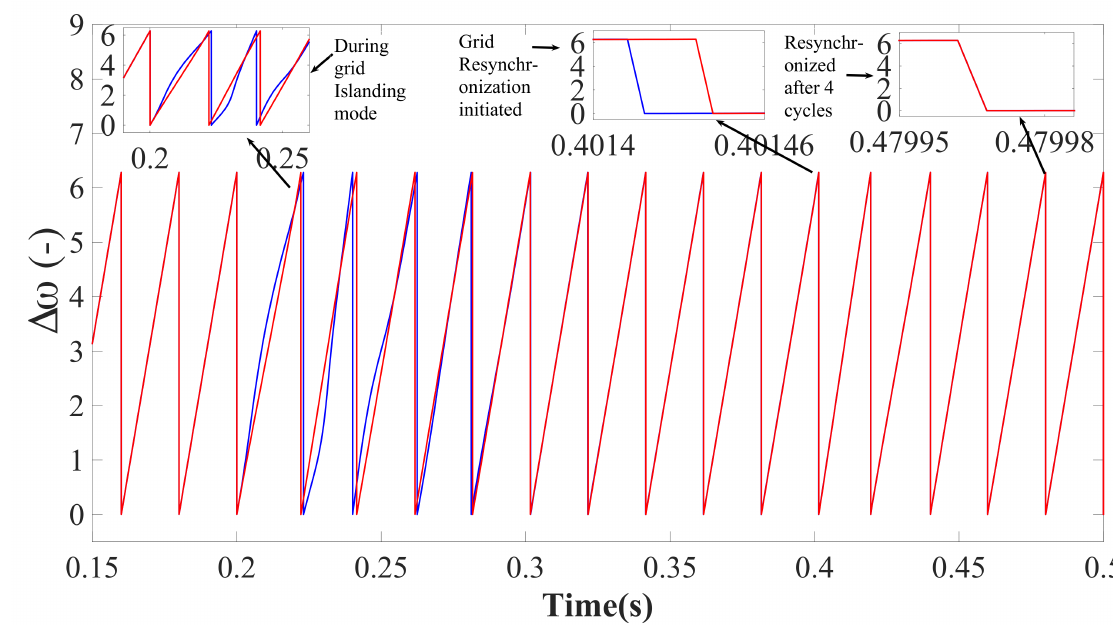
Figure 17. Comparison of ∆ ω of v Sabc and v Labc during grid islanding and re-synchronization.